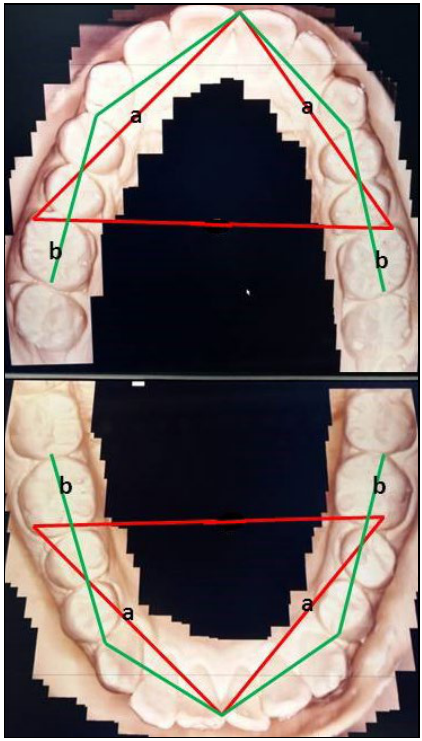
Figure 3. Arch dimension measurements: (a) arch length, (b) arch